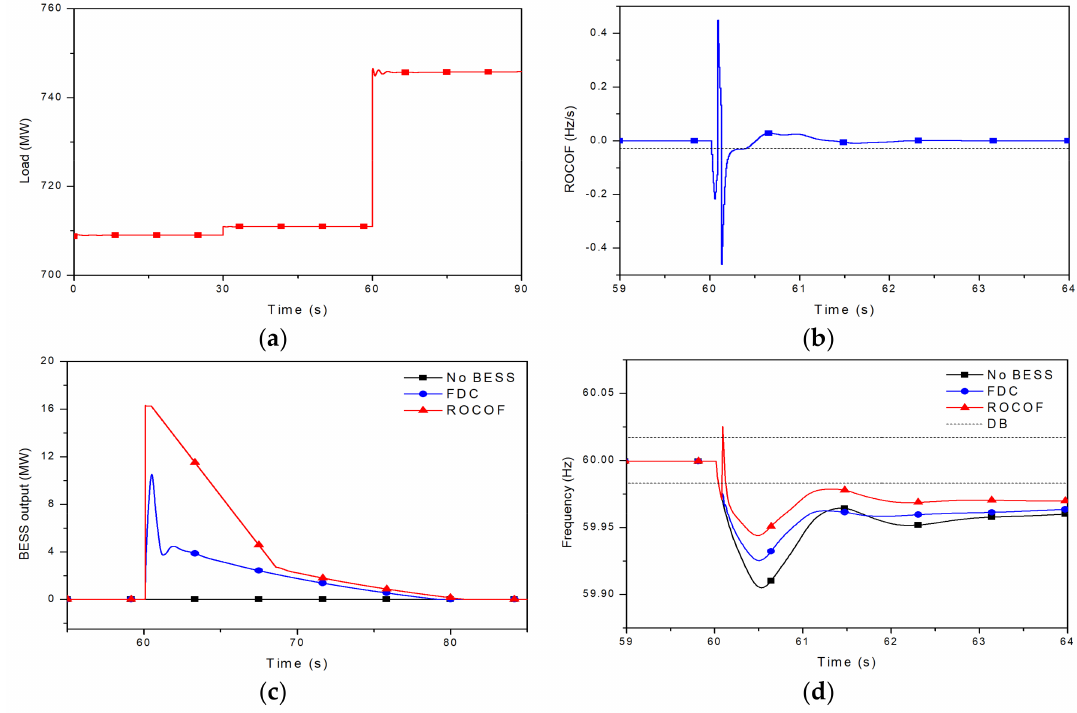
Figure 6. Power system load is increased by 5%: ( a ) Power system load; ( b ) Rate of Change of Frequency (ROCOF); ( c ) BESS output; ( d ) Power system